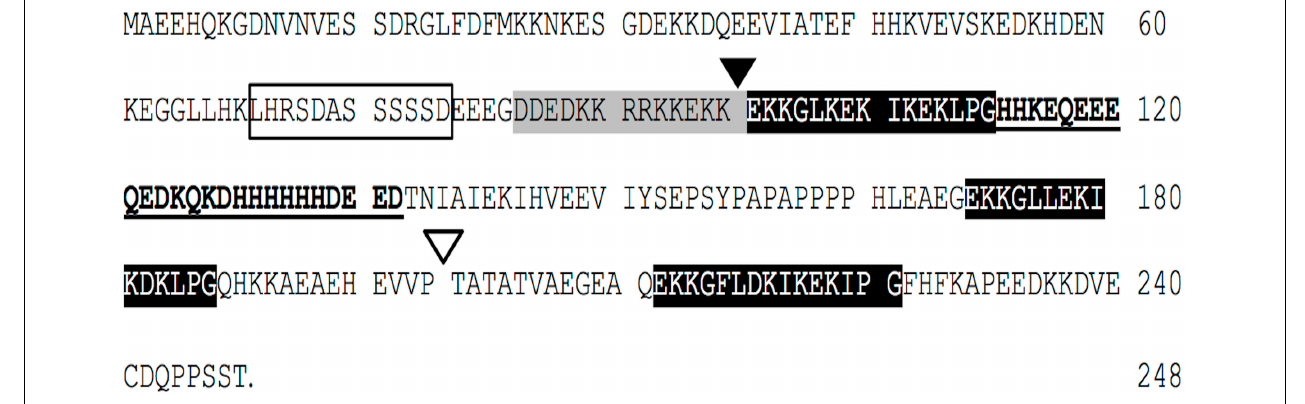
(gray boxes), K-segments (black boxes), and histidine-rich motif (in bold). The end of S version (black triangle), and the end of SK 2 version (open triangle); histidine rich region deleted (underlined